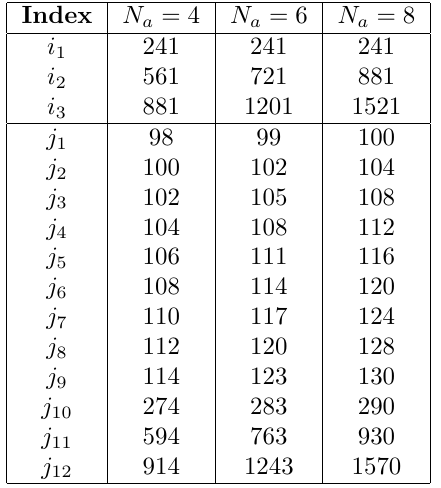
Table 4: Optimization indices for N a = 4 , 6 and 8 ac-